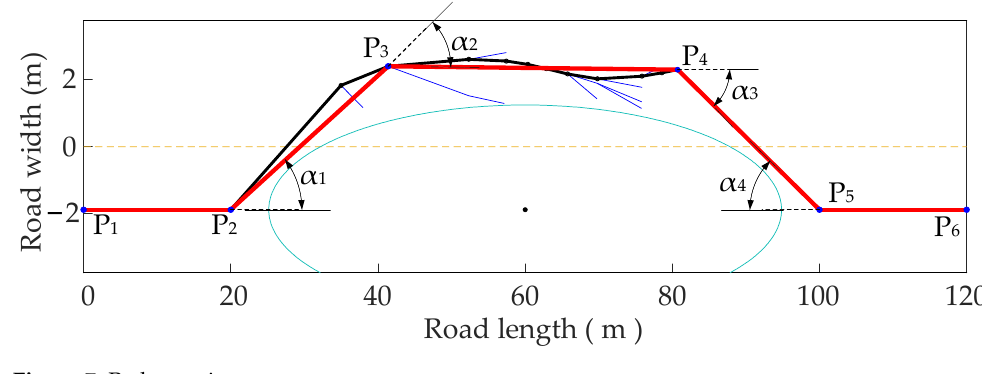
Figure 7. Path pruning. Cubic B-Spline Smoothing